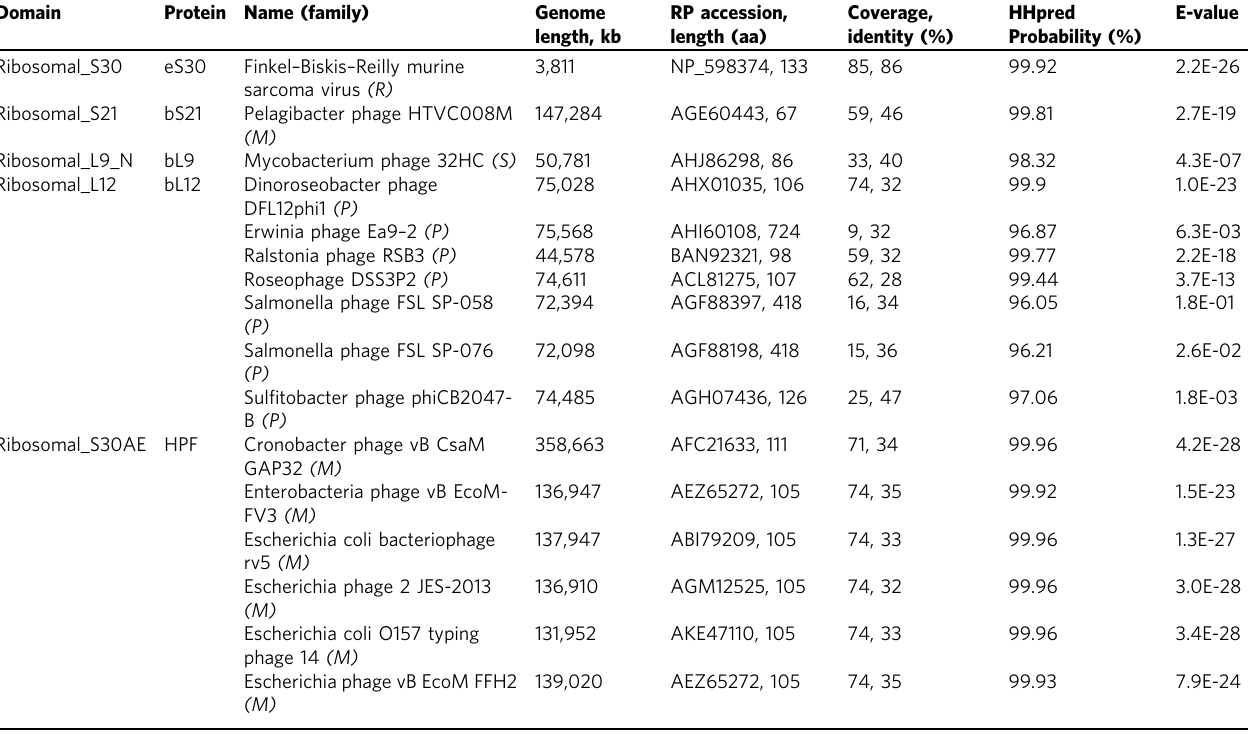
Table 1 Ribosomal protein domains found in cultivated viruses